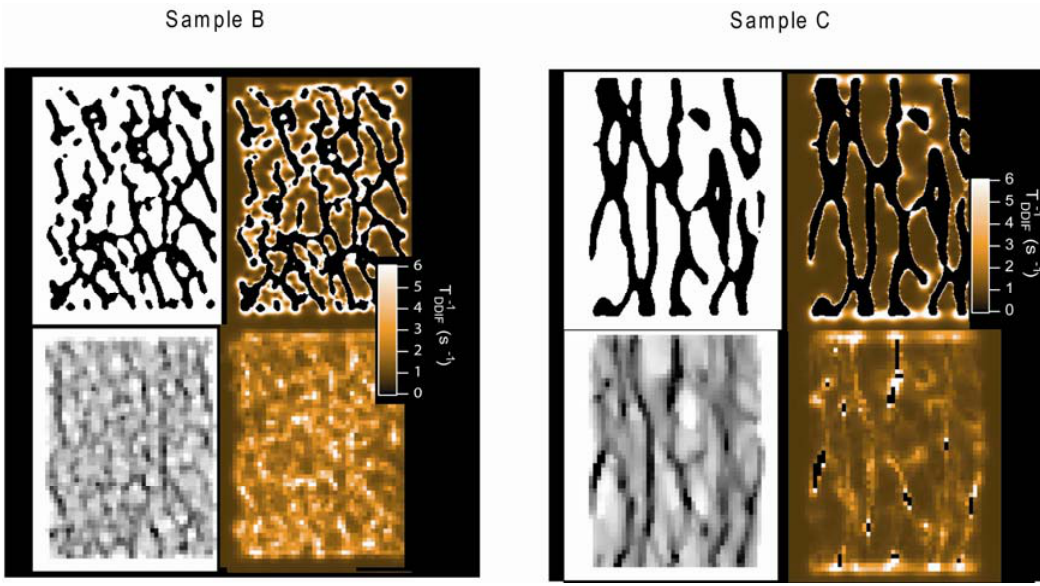
Figure 11. Calculated local DDIF contrast (internal gradient map) of samples B and C. For each sample, the upper left is the binarized high-resolution μ CT image. The upper right is the high-resolution calculated DDIF map. The lower left is the downsampled low-resolution image, and the lower right is the calculated low-resolution DDIF map. Reproduced from Reference [24] with